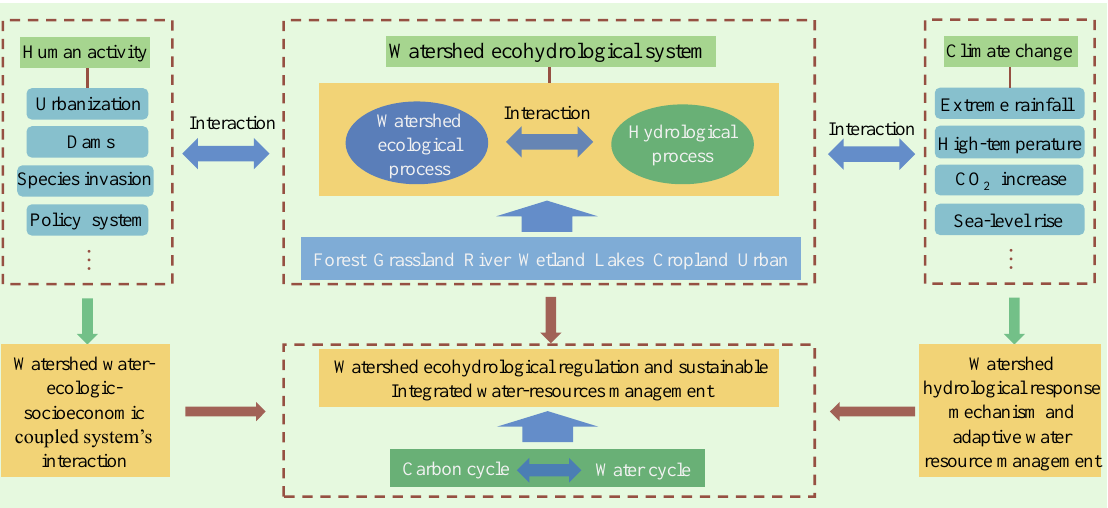
Figure 1. Key objectives ecohydrological processes in watersheds.